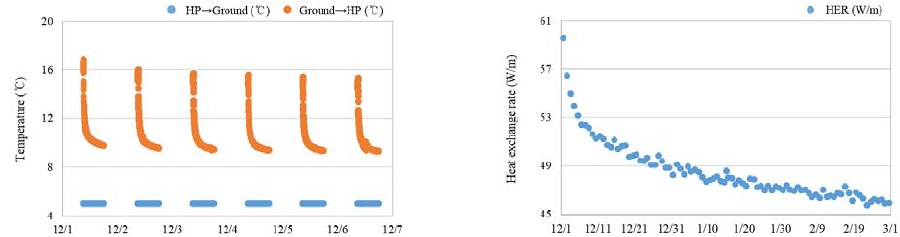
Figure 4. EWT (Entering Water Temperature) and HER (Heat Exchange Rate) of base case. Figure 5 indicates the HER of geothermal system with an unusual 300 m long deep GHX and a